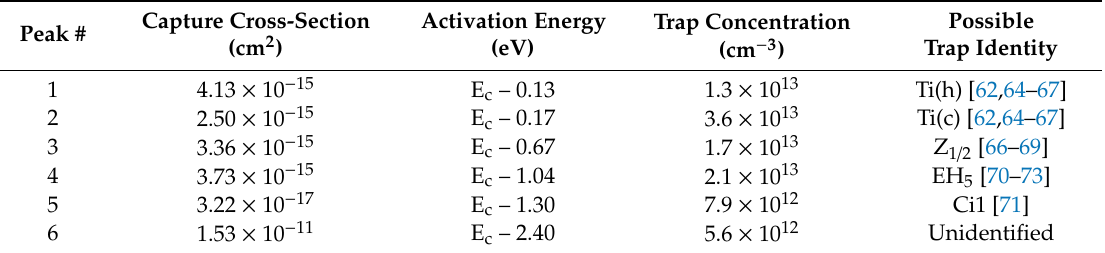
Table 3. Defect parameters acquired from DLTS spectroscopy for a 50 µ m n-type Ni / 4H-SiC (n-S50)